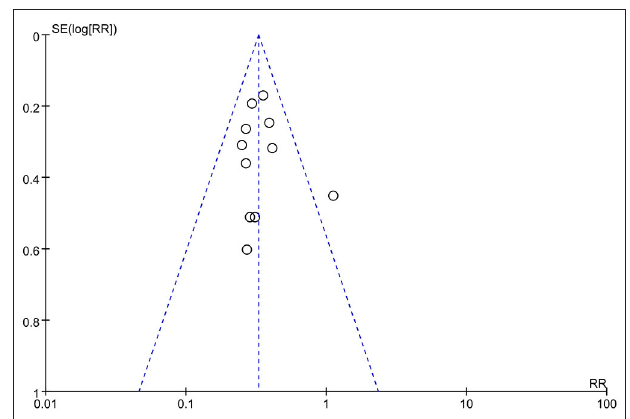
FIGURE 8 | Funnel plot of the effect of proton-pump inhibitor therapy on patients with chronic obstructive pulmonary disease.